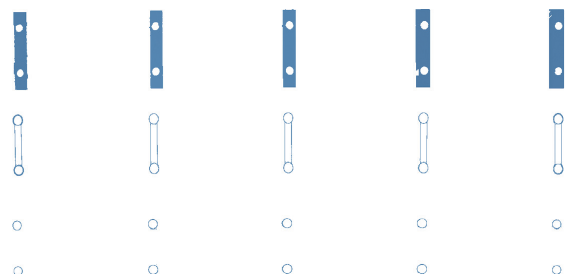
Figure 18: Segmentation of the pier point cloud structure unit.